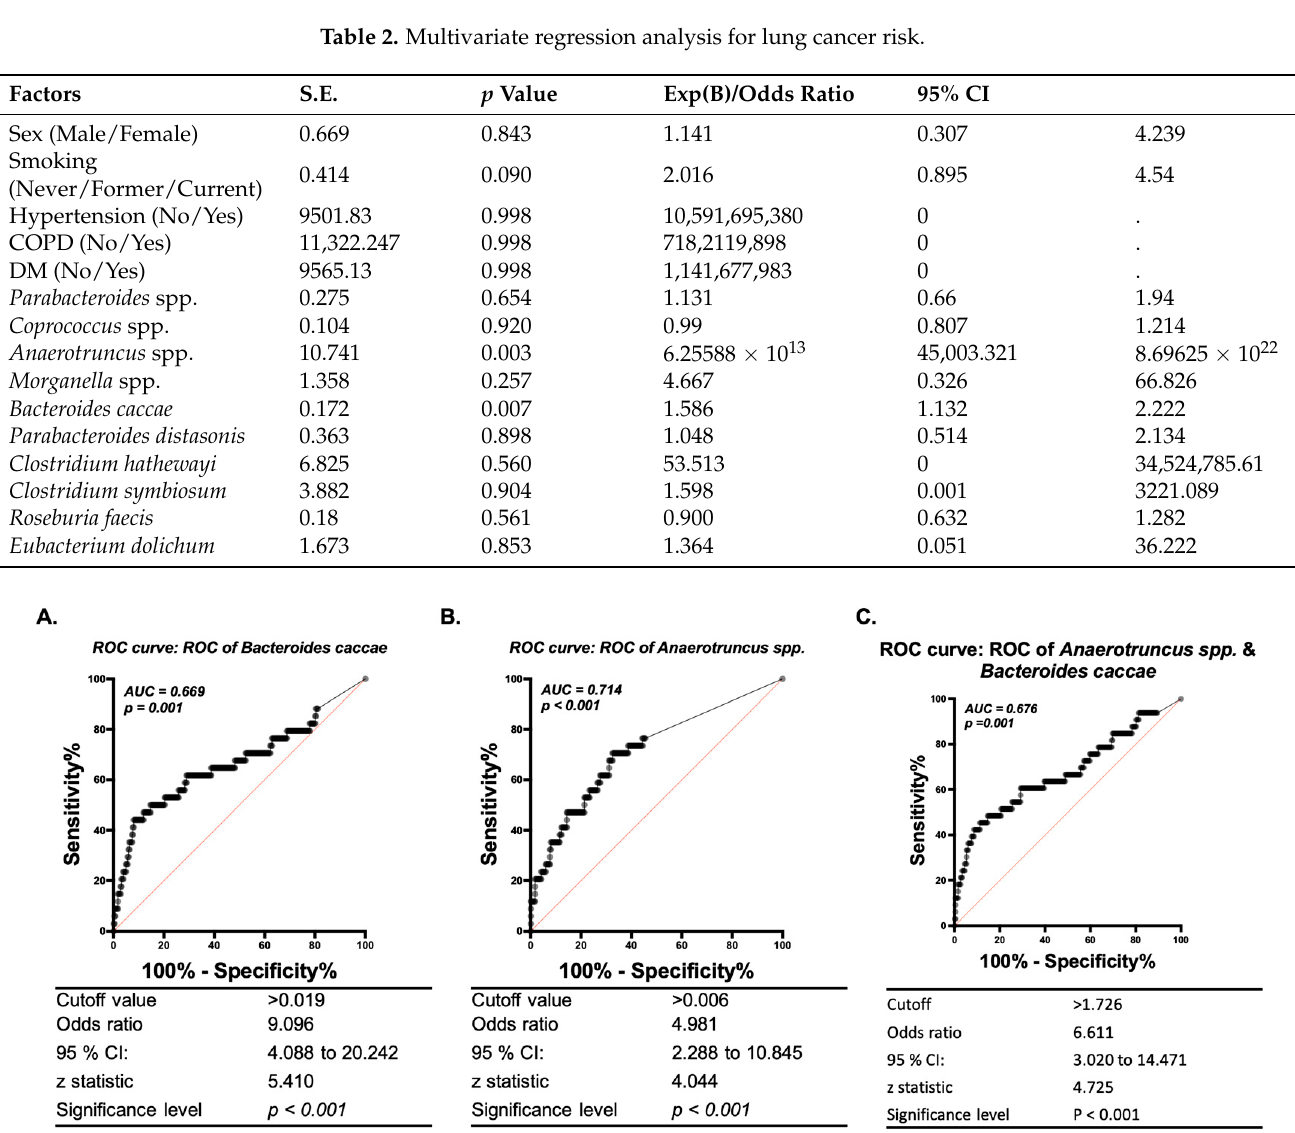
Table 2. Multivariate regression analysis for lung cancer risk .